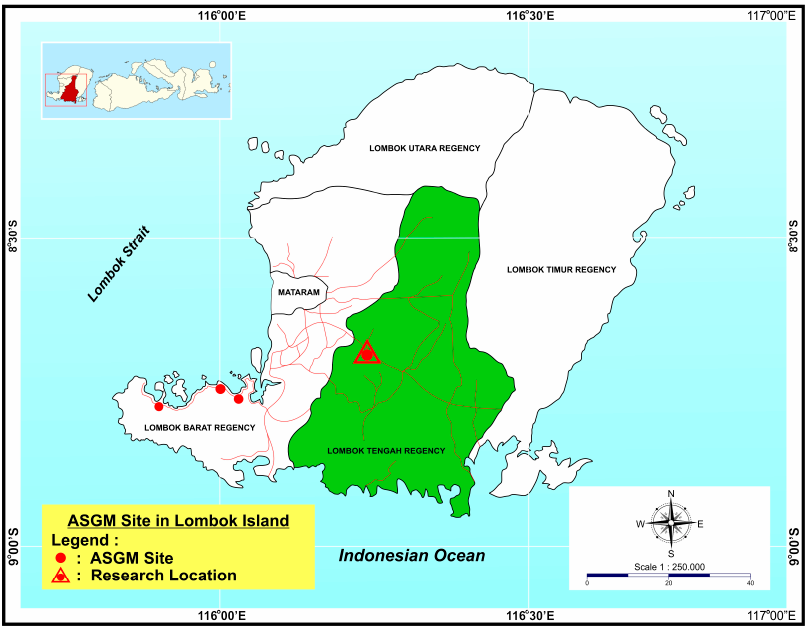
Figure 1. Location of the phytomining demonstration trial in Pringgarata District, Central Lombok Regency, West Nusa Tenggara, Indonesia.